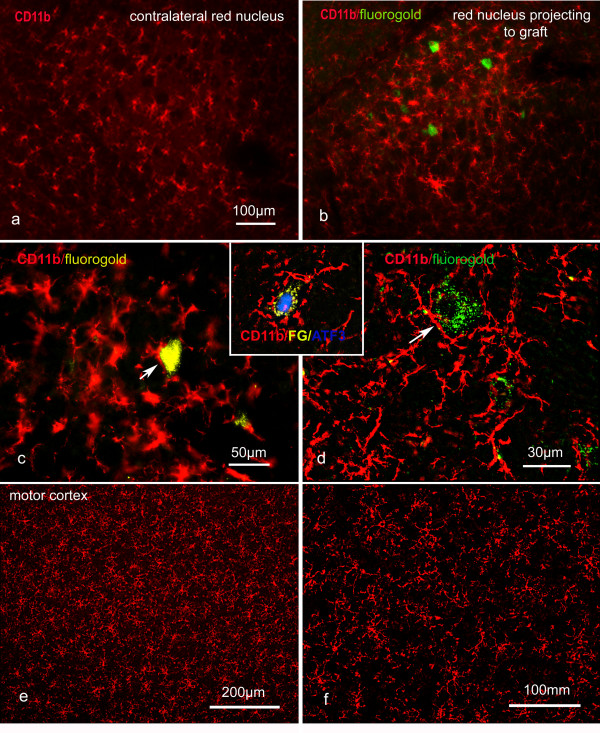
Microglia in the red nucleus (a-d and inset) and motor cortex (e, f) 4 weeks after nerve graft implantation into the rubrospinal tract and cervical dorsal columns respectively. Neurons with regenerating axons were retrogradely labelled with fluorogold. Microglia established close contacts with regenerating rubrospinal neurons (arrows), which also expressed ATF3 (inset). No retrogradely labelled corticospinal neurons were detected (e and f) and there was no microglial activation in the motor cortex. (a-c) are non-deconvolved and (d-f plus inset) are deconvolved images. The scale bar in (a) also applies to (b).